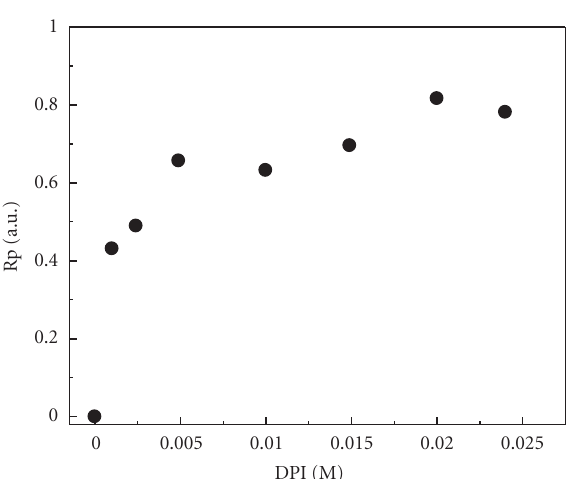
Figure 3: initial rates of polymerization of AA 2M in water (pH = 10) in the presence of Rz 4 × 10 − 6 M as a function of DPI concentration.